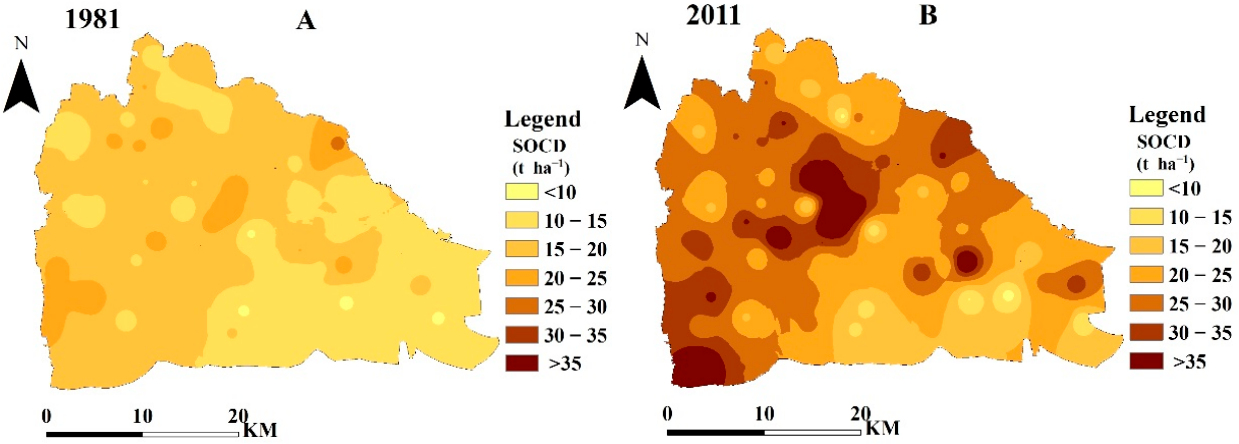
Figure 2. SOCD distribution maps of Fengqiu county in 1981 ( A ) and 2011 ( B ).